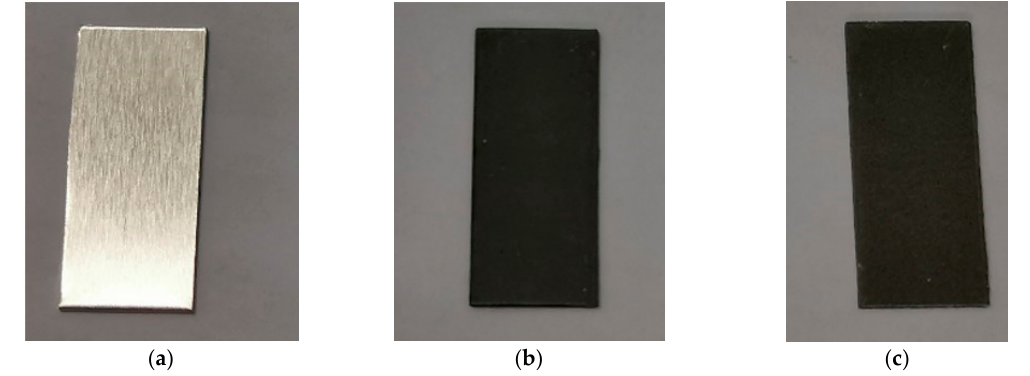
Figure 1. The real photos of ( a ) the untreated aluminum alloy, ( b ) the laser treated aluminum alloy, and ( c ) the cleaned and laser treated aluminum alloy samples.